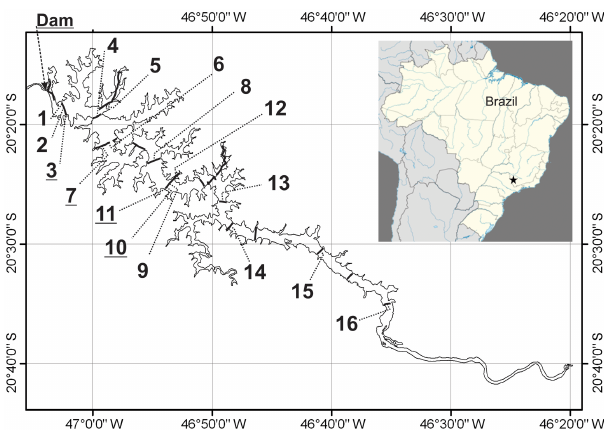
Figure 1. Location of the Mascarenhas de Moraes reservoir (black star in the map of Brazil), its dam and the sampling sites. Underlined numbers correspond to sites located on the margins; other numbers correspond to pelagic